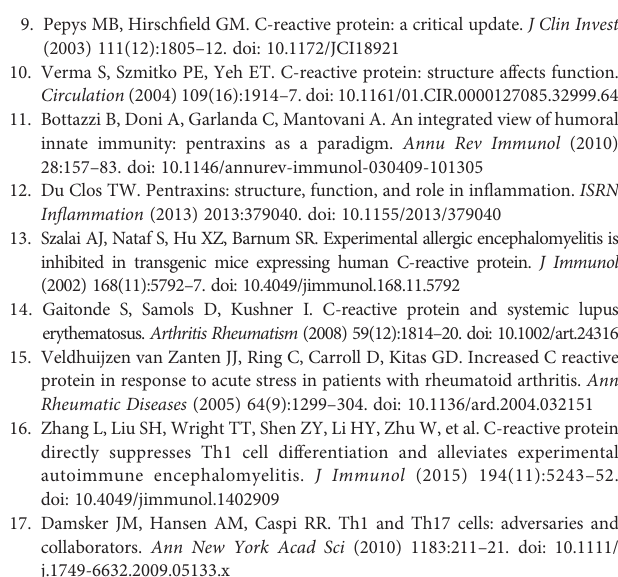
Supplementary Figure 1 | CRP alleviates MOG-immunized EAE severity both in WT mice and Fc g R2B-/- mice. (A) The clinical sores of EAE were recorded daily in WT mice and Fc g R2B-/- mice respectively. (B) The body weight was recorded daily in WT mice and Fc g R2B-/- mice, which is consistent with EAE severity. (C) The degree of demyelination of each group was shown in LFB staining. (D) HE staining displayed the in fi ltration of immune cells for each groups. Data are presented as mean ± SEM, p < 0.05 was considered statistically signi fi cant. Supplementary Figure 2 | CRP effects the antigen presenting ability of moDCs from WT mice. (A) Antigen presenting molecular MHC-II, CD86, CD80, CD70, COSL-1, PD-L1, PD-L2, OX40L, BTLA, HEVM, SLAM and 4-1BBL were screened by qPCR (n = 6). (B) Flow cytometry of PD-L1 was no apparent difference